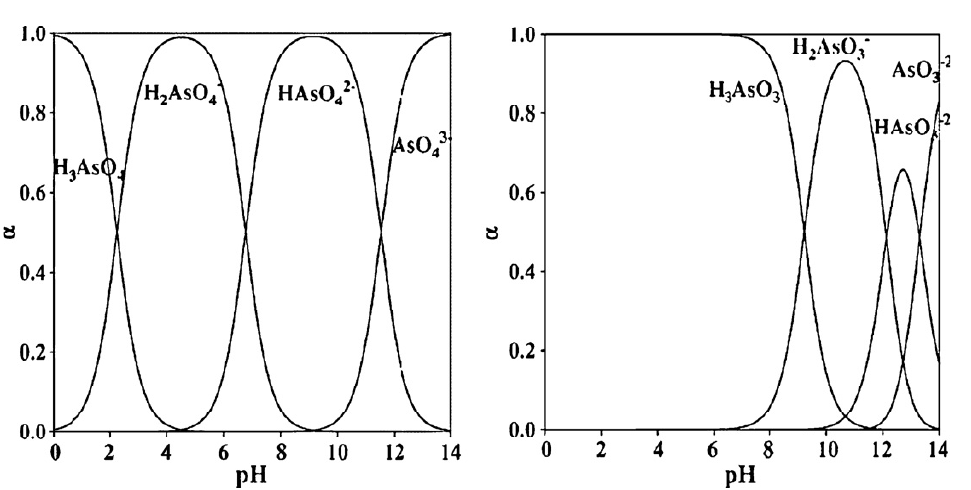
Figure 5. Distribution of arsenate and arsenite as a function of pH (after [28]).